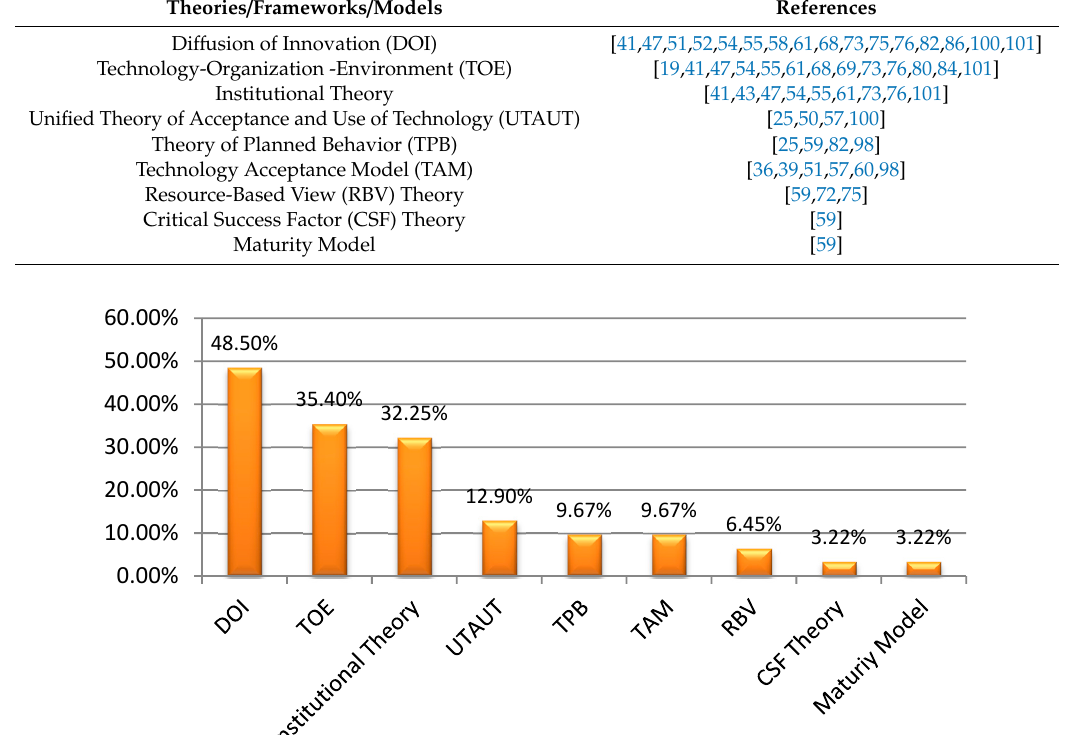
Table 5. Theories and models used for business intelligence system (BIS) adoption and acceptance.